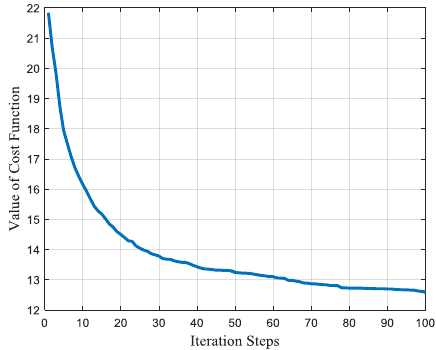
Figure 6. The convergence process of the waveform design algorithm.